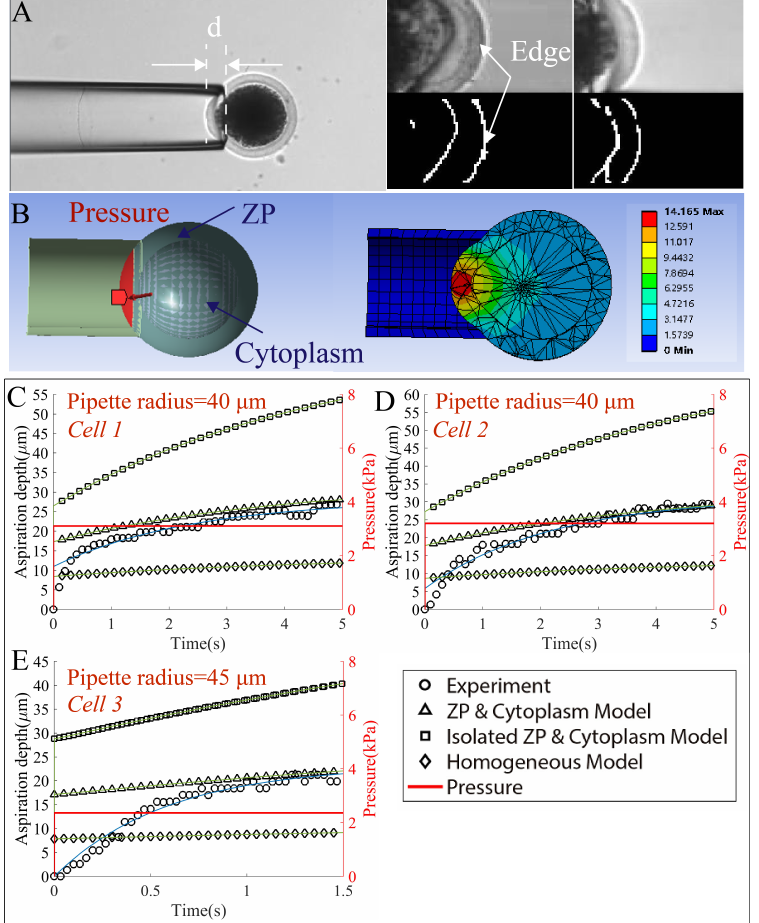
Figure 6. Performance comparison between the simulation and experimental results obtained from the micropipette aspiration experiment. ( A ) The aspiration of an oocyte using a micropipette on an in-house robotic micromanipulation platform. The cell edge was detected with a subpixel precision to compute the aspiration depth d . ( B ) The layered ZP and cytoplasm model. Given the pressure (indicated in red), the portion of cell gradually flowed into the micropipette. ( C – E ) Comparison of the experimental results (circle) with the simulation results of the three models (ZP and cytoplasm: triangle; isolated ZP and cytoplasm: square; homogeneous model: diamond) under the different settings of micropipette radius and pressure. Please note a step pressure was difficult to produce in the experiment; therefore, the instantaneous elastic deformation in response to the step pressure was not obvious for the experimental results. For the simulation results, the viscoelastic creep behavior was least obvious for the homogeneous model with the smallest instantaneous elastic